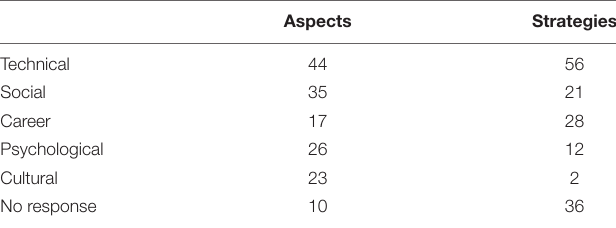
TABLE 5 | Summary of coded responses to important aspects and strategies open-ended questions.